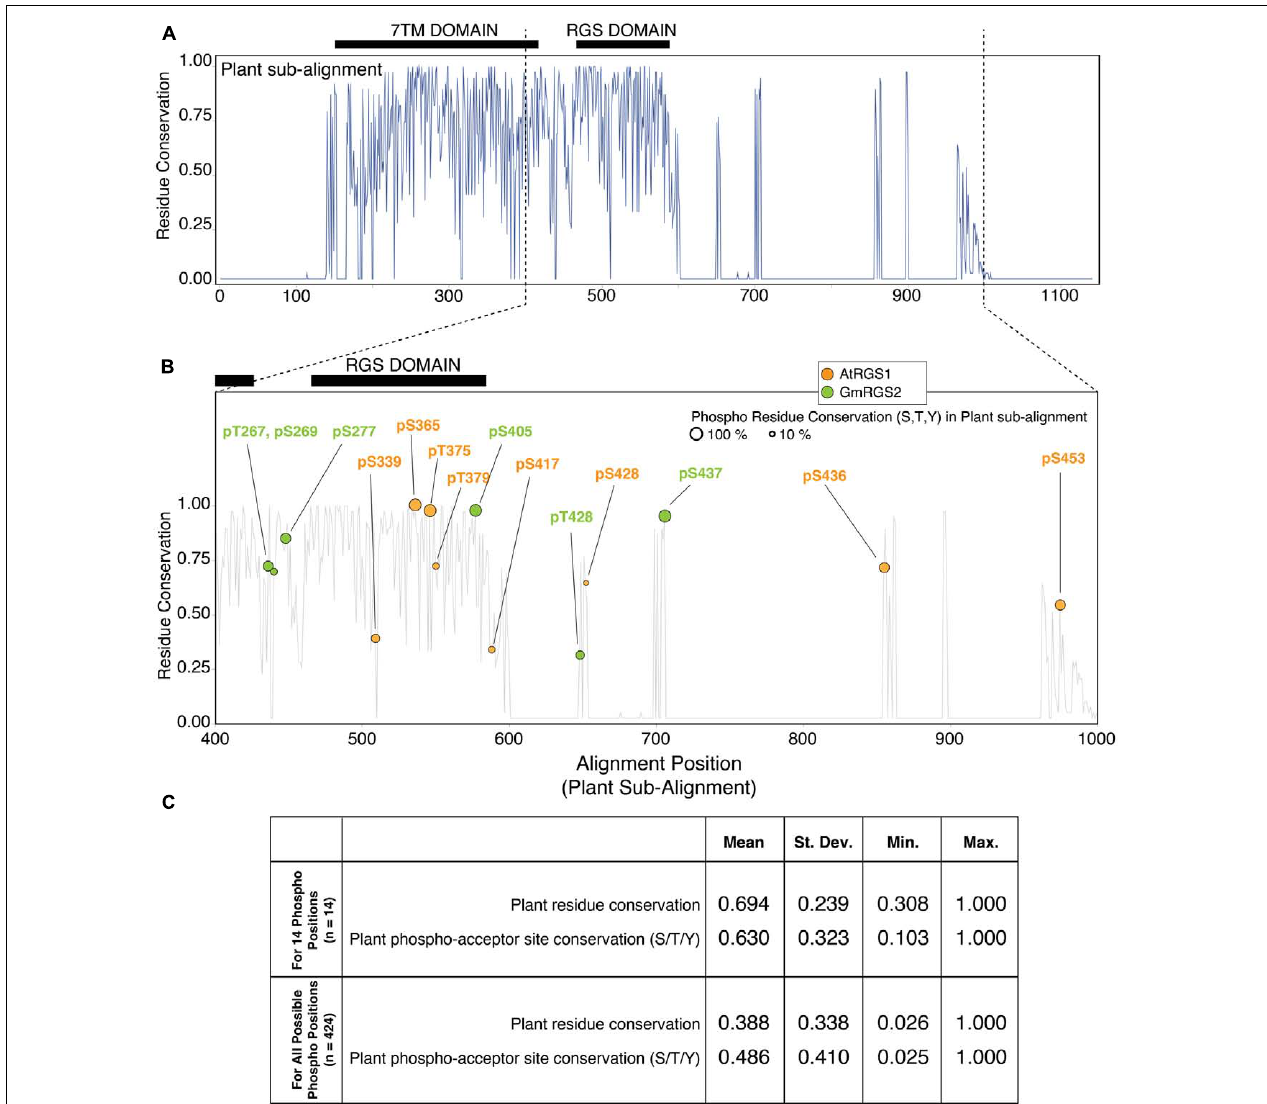
FIGURE 2 | Plant phosphosites are enriched at well-conserved phospho-acceptor positions across 7TM-RGS proteins. (A) Residue conservation (% identity) derived from multiple sequence alignment (MSA) of 7TM-RGS proteins from plants. Black bars indicate the position of the 7TM and RGS domains. (B) Alignment position locations of plant phosphosites observed in the cytoplasmic C-terminal end of 7TM-RGS proteins. Only alignment positions 400–1000 are shown. Size of each circle indicates the percent conservation of phospho-acceptor residues (S,T,Y) within the alignment position of each observed phosphosite. (C) Table of the average residue conservation (% identity) and phospho-acceptor residue conservation (% S,T,Y) in the 14 phosphosite alignment positions (top) versus all other alignment positions that harbor at least one phospho-acceptor residue in the cytoplasmic region of